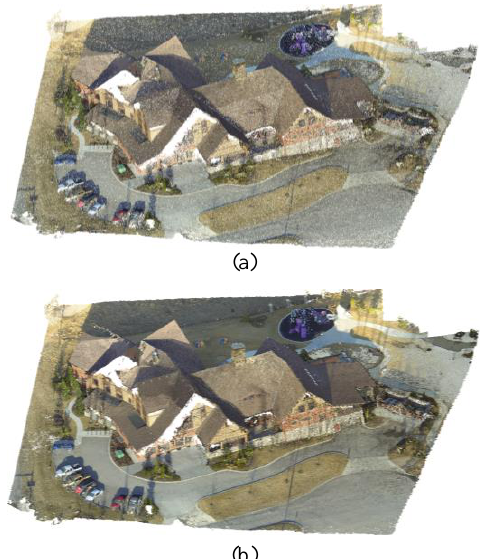
Figure 8: Visual comparison of the dense point clouds achieved using (a) the proposed progressive technique and (b) image-based